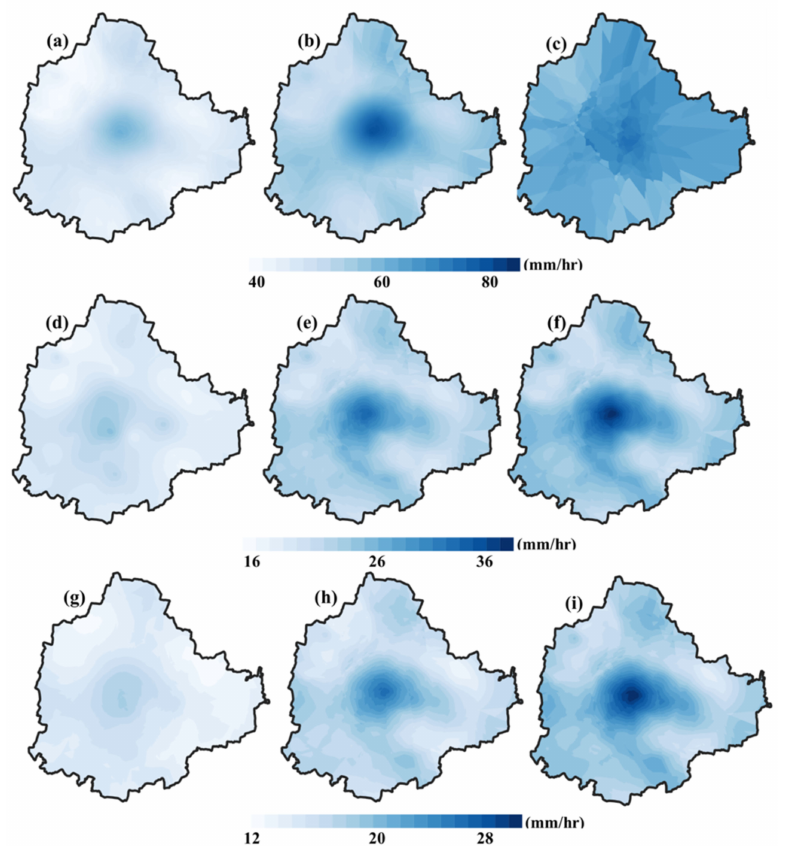
Figure 6. Rainfall intensity values across Bangalore for a given storm duration and frequency. Columns represent three return periods—( a – c ) 10, ( d – f ) 25, and ( g – i ) 50 years—whereas the rows represents three durations: ( a , d , g ) 1, ( b , e , h ) 3, and ( c , f , i ) 5 h. KSNDMC stations that witnessed stationarity in their annual maximum hourly rainfall series were considered for the analysis. Spatial interpolation was performed according to the kriging